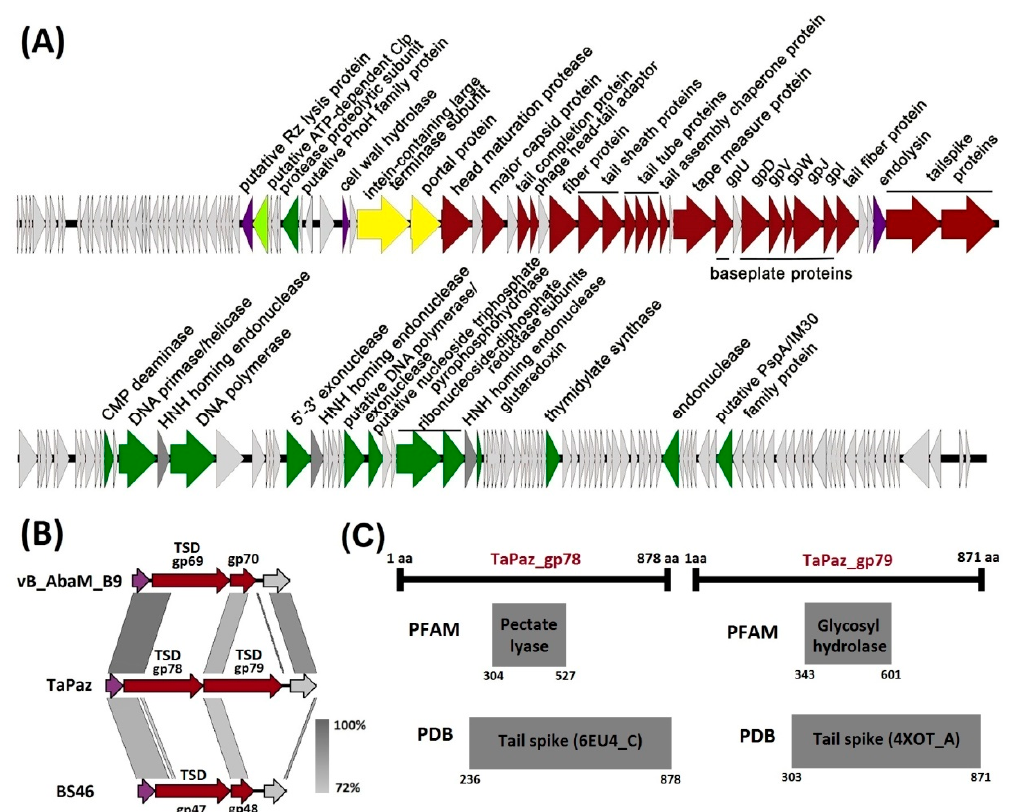
Figure 3. ( A ) Genetic map of phage TaPaz. The ORFs are represented as colored arrows according to functional predictions: green, genes coding for enzymes of nucleotide metabolism and proteins involved in DNA replication and repair; light green, gene for protein with protease activity; yellow, genes for packaging of DNA; red, structural protein and phage assembly protein genes; violet, lysis protein genes; dark grey, HNH homing endonuclease genes; light gray, hypothetical protein genes. The direction of an arrow shows the direction of transcription. ( B ) Comparison of regions of vB_AbaM_B9, TaPaz, and BS46 genomes that contain genes encoding tailspikes: violet, genes coding endolysins; red, structural protein genes; light gray, hypothetical protein genes; tailspike depolymerases are marked as TSD. ( C ) HHpred-detected similarities between TSDs TaPaz_gp78 and TaPaz_gp79 and proteins from the Pfam and PDB databases.